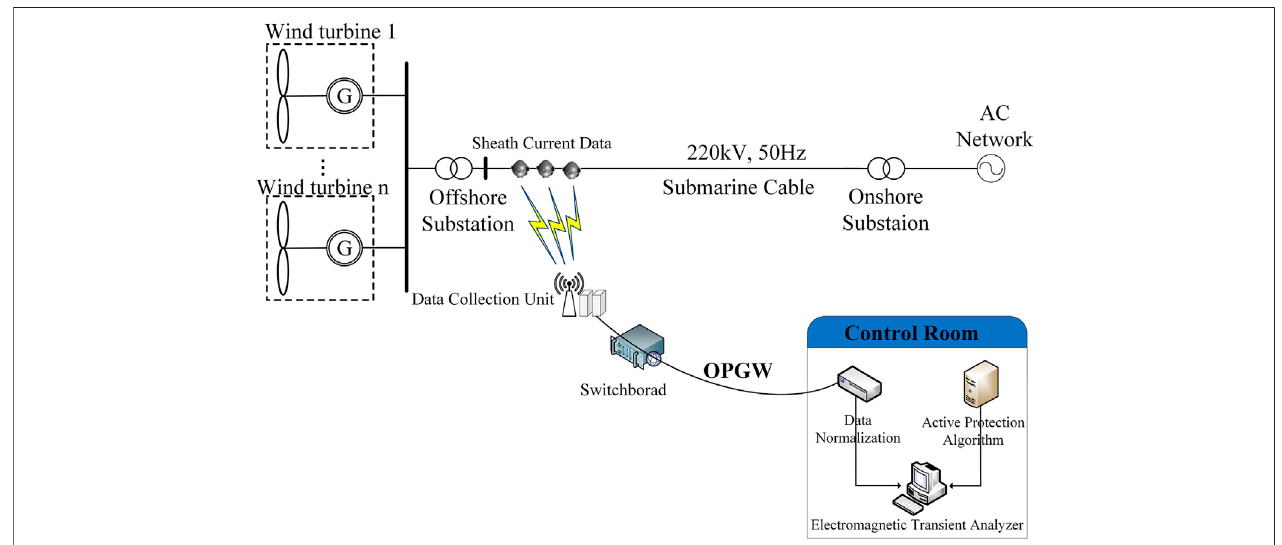
FIGURE 12 | Hardware topology of sheath current-based active protection